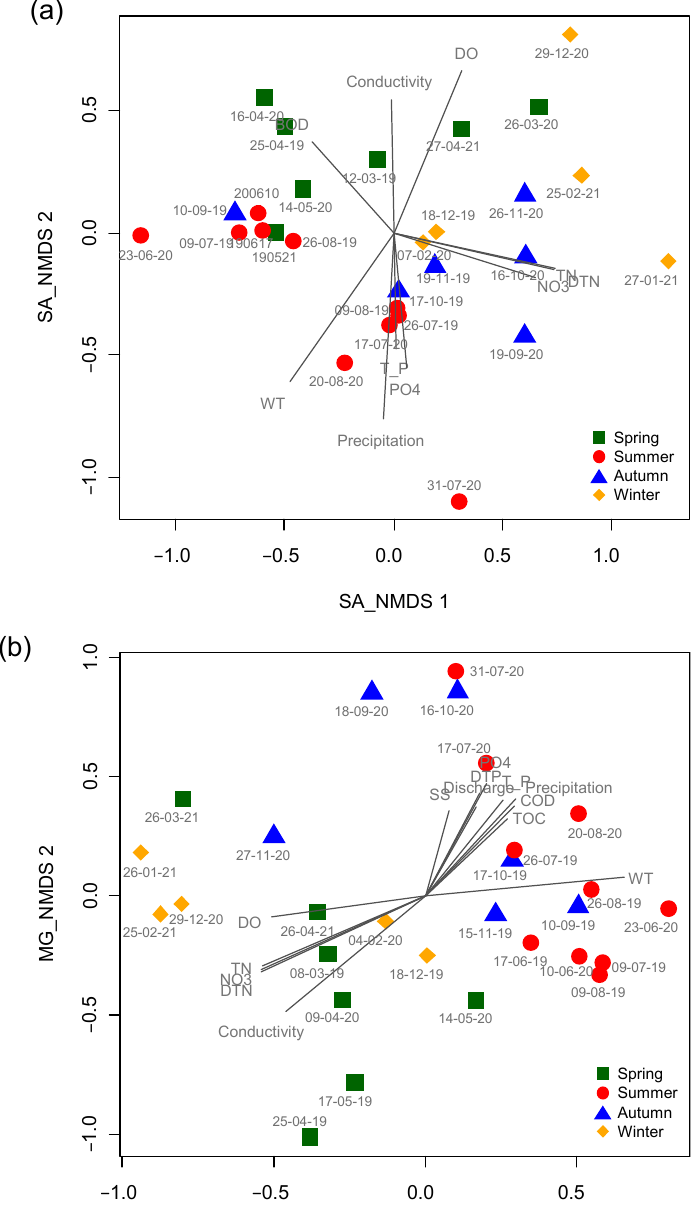
Figure 4. Patterning the temporal changes in micro-eukaryotic assemblages using non-metric multidimensional scaling ordination. ( a ) SJ and ( b ) MG sites. Different colored symbols represent different seasons. Spring: green square; summer: red circle; autumn: blue triangle; and winter: yellow diamond. The gray lines correspond to environmental factors significantly related to assemblage composition. The longer the length, the higher the correlation magnitude (R). The meaning of abbreviations for the environmental variables is presented in Table